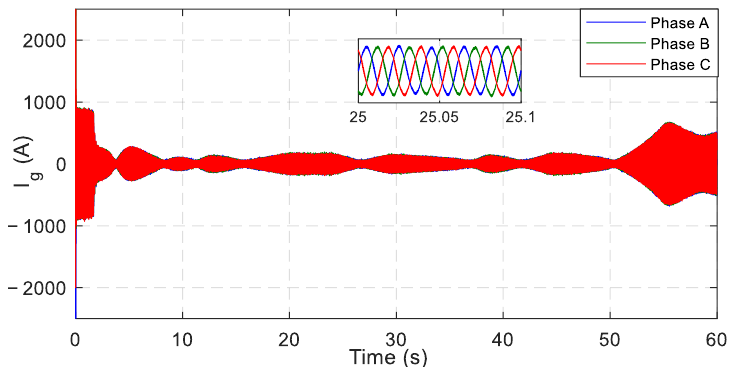
Figure 15. Grid currents of WECS with PI controller.